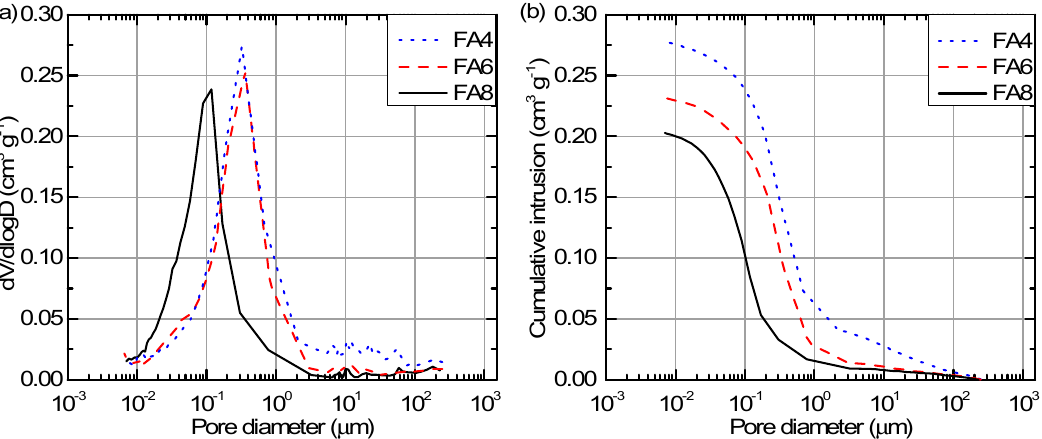
Figure 2. Mercury intrusion porosimetry (MIP) results of the end products indicating the pore size distribution based on (a) differential pore volume, d V /d log D ; (b) cumulative pore volume. Table 3. Pore size distribution (%) and strength of the end products after 28 days curing. Sample